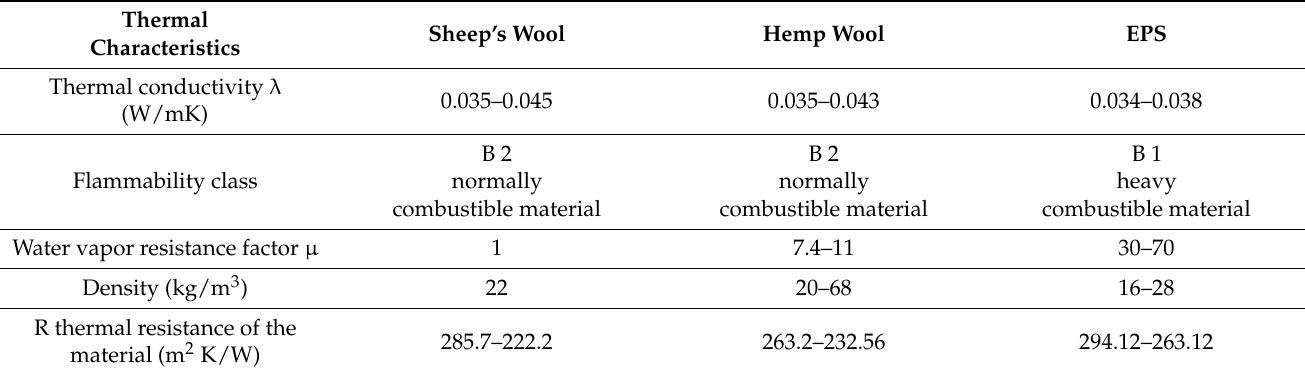
Table 2. Thermal characteristics of sheep wool, hemp wool and expanded polystyrene.